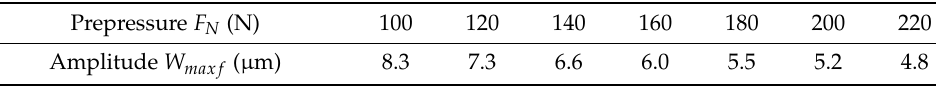
Table 2. Stator amplitude test results under different prepressures.